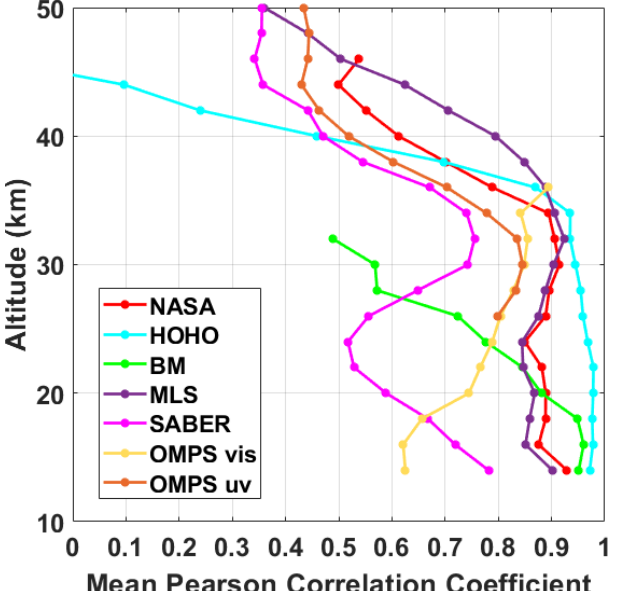
Figure 8. Vertical profiles of the correlation coefficient calculated for ozone concentrations measured by the various HOPS instru- ments with respect to HOH measurements. Correlation is taken over the 10 nights of the HOPS campaign data vertically integrated to 2km.